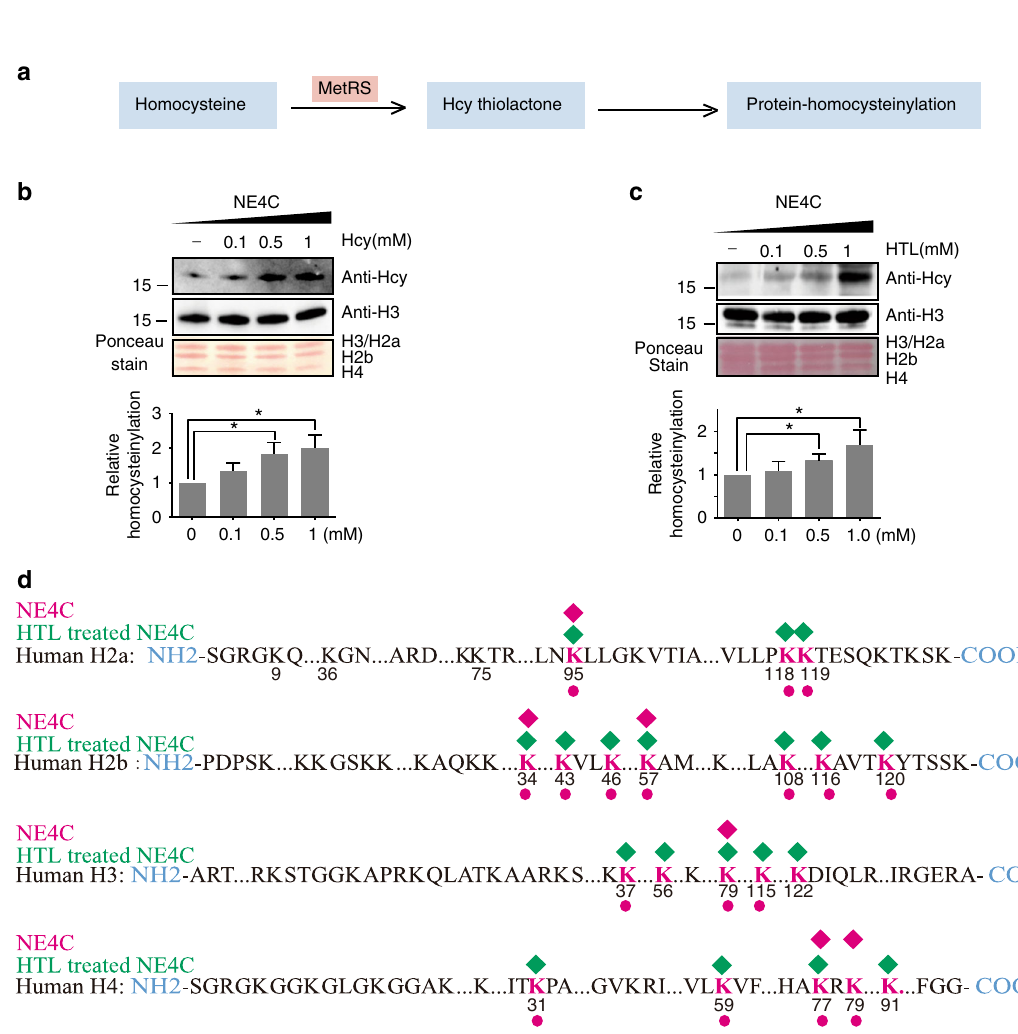
Fig. 3 Intracellular histones homocysteinylation. a Schematic diagram of the process for intracellular protein homocysteinylation by Hcy. b , c Western blotting analysis of H3 homocysteinylation in NE4C cells treated with increasing doses of Hcy ( b ) or HTL ( c ) for 4 h. Data represent mean ± SEM ( n = 3). * p <0.05 vs. 0 mM Hcy ( b bottom chart) or HTL ( c bottom chart); the p values were calculated with unpaired t test. d Schematic illustration of histone homocysteinylation sites identi fi ed from NE4C treated with or without 0.5 mM HTL for 4 h using HPLC-MS/MS. The detected homocysteinylation sites from treated or untreated samples are shown in green or red diamond shape, respectively. The number underneath each red lysine residue (K) represents the position of the particular lysine residue within each respective histone. Homocysteinylation sites detected in both normal fetal brain (Fig. 1b) and NE4C are marked with red dots under numbering of lysine residues